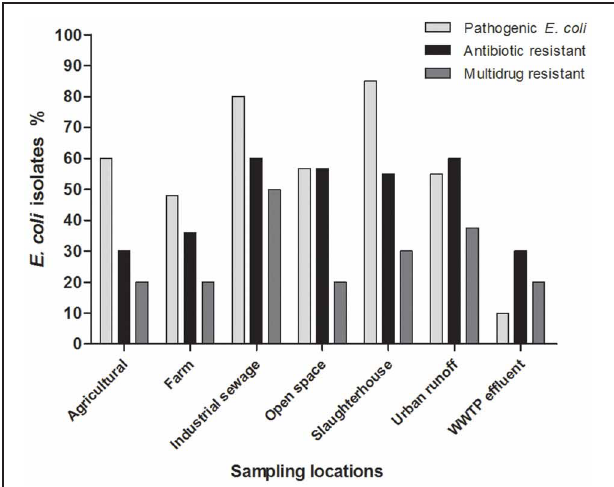
FIGURE 5 | Antimicrobial resistant, multidrug resistant, and potentially pathogenic Escherichia coli isolates found according to the sample location. aWWTP-E, wastewater treatment plant